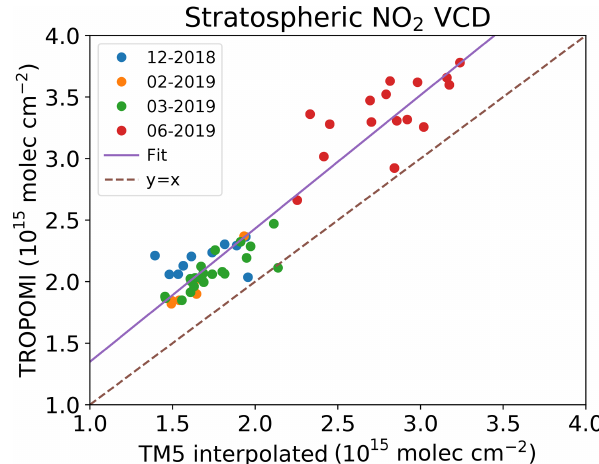
Figure 7. Scatter plot of TROPOMI stratospheric NO 2 vertical col- umn densities versus MAX-DOAS stratospheric NO 2 vertical col- umn densities. The MAX-DOAS measurements are taken from the collocated TROPOMI pixels. The correlation coefficient is 0.93.